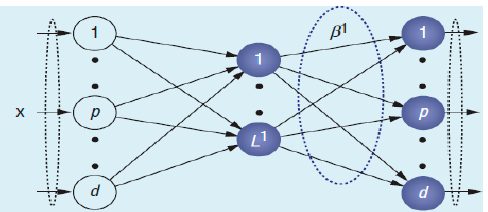
Figure 2. The structure of extreme learning machine (ELM) model.